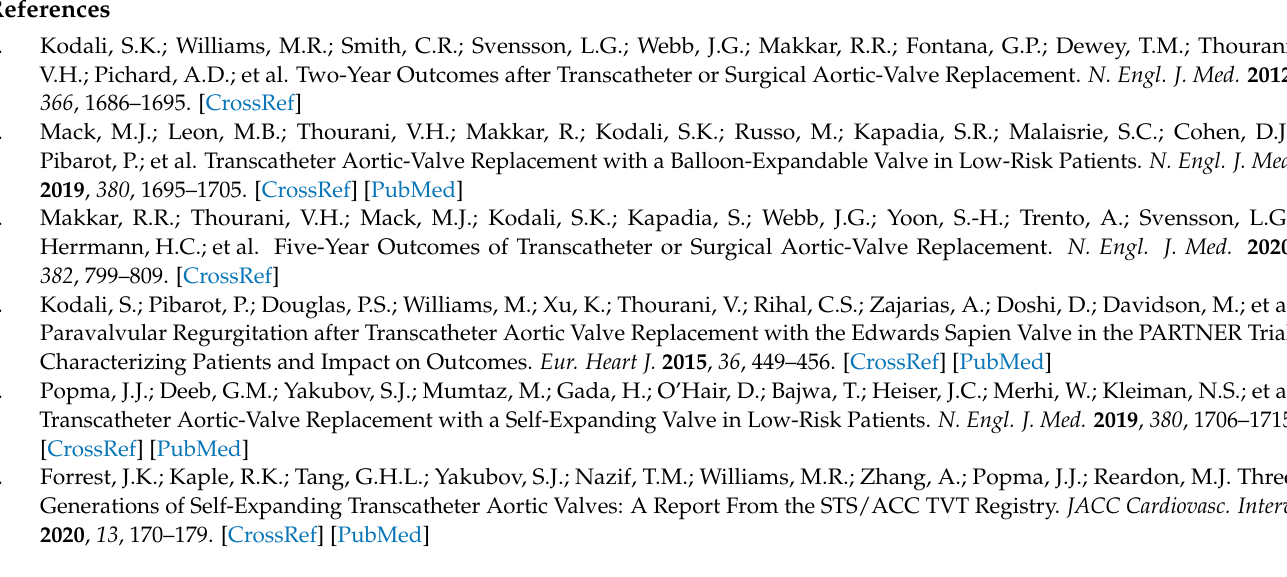
Table S3: Post-implantation aortic regurgitation severity after SE-TAVR